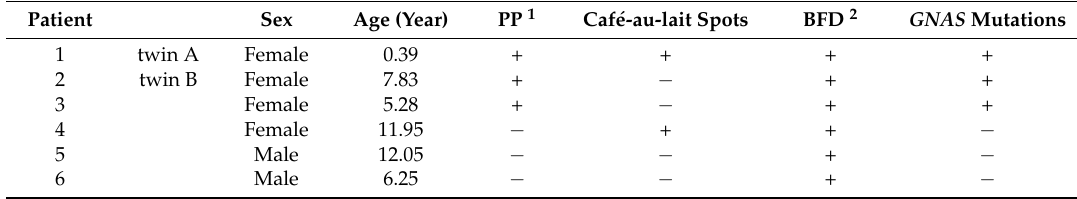
Table 1. Clinical characteristics of six patients with MAS or